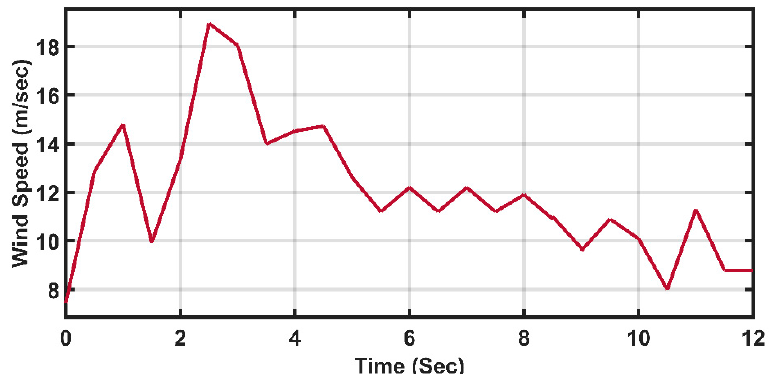
Figure 34. Wind-speed profile of faulty fourth case.